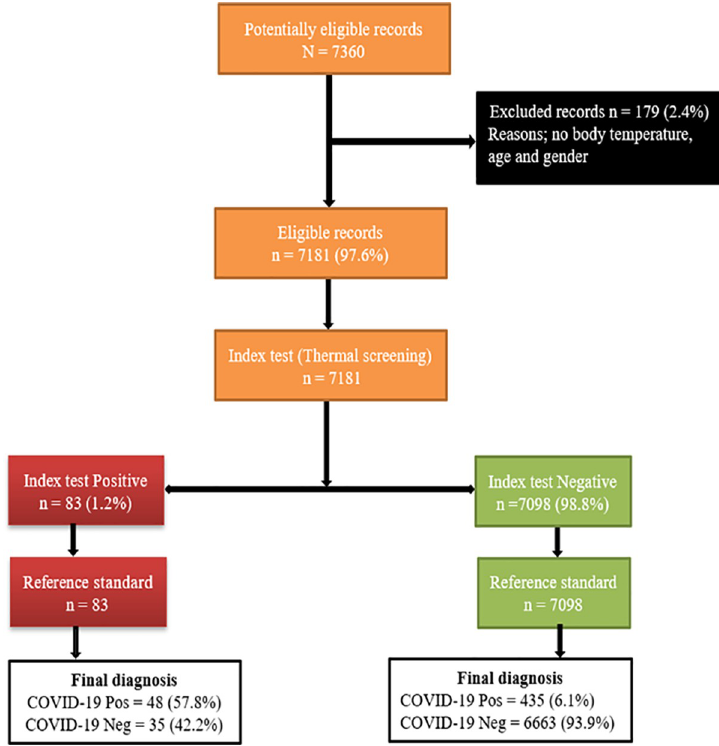
Fig 2. The flowchart for thermal screening in comparison to Xpert Xpress SARS CoV-2 testing.